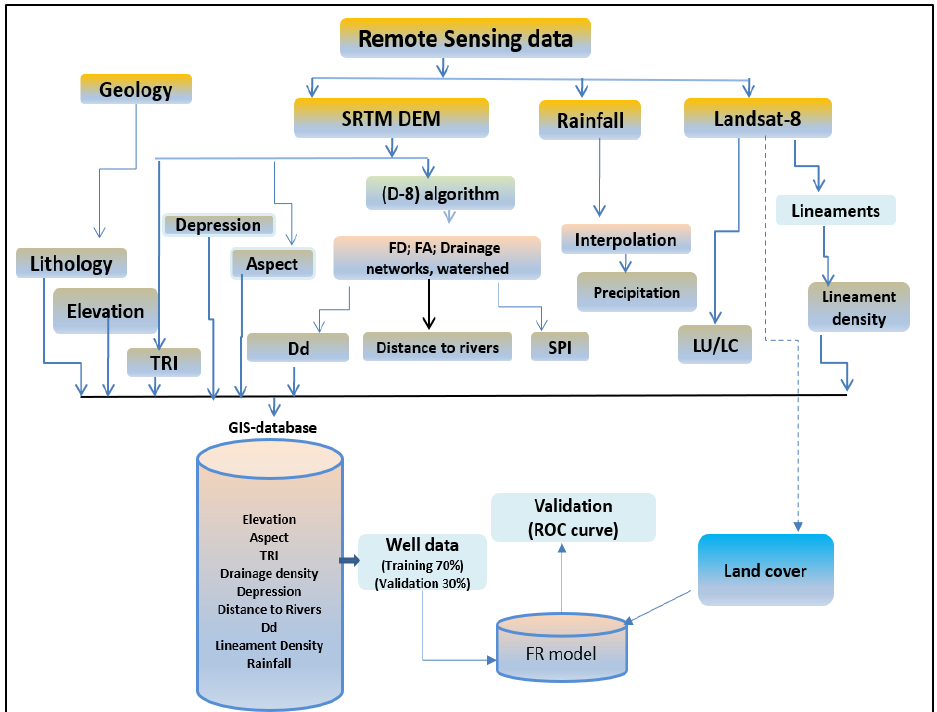
Figure 2. Data and methods utilized in the present study include the factors influencing groundwater occurrence. Abbreviations: Drainage density (Dd), Receiver Operating Characteristic (ROC) curve, Terrain Roughness Index (TRI), Frequency Ratio (FR), Deterministic-8 (D-8), Land use/Land Cover (LU/LC), Flow direction (FD), Flow Accumulation (FA).